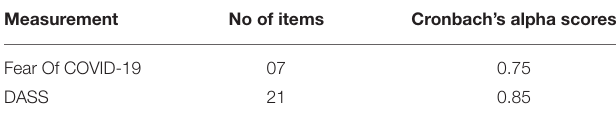
TABLE 3 | Cronbach’s alpha scores for each